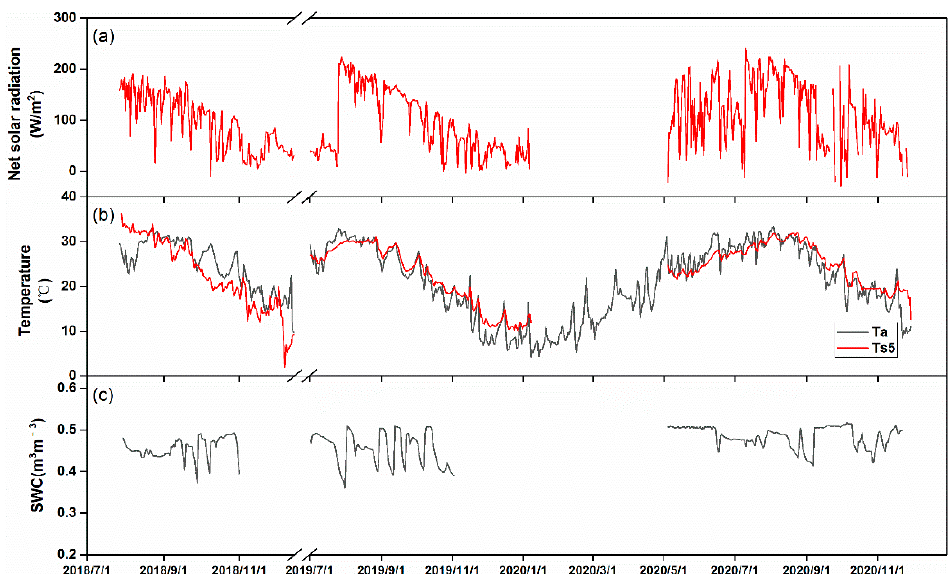
Figure 4. Seasonal variations in ( a ) net solar radiation (R n ); ( b ) T a and soil temperature at 5 cm depth (T s5 ) and ( c ) soil water content at 5 cm depth (SWC).